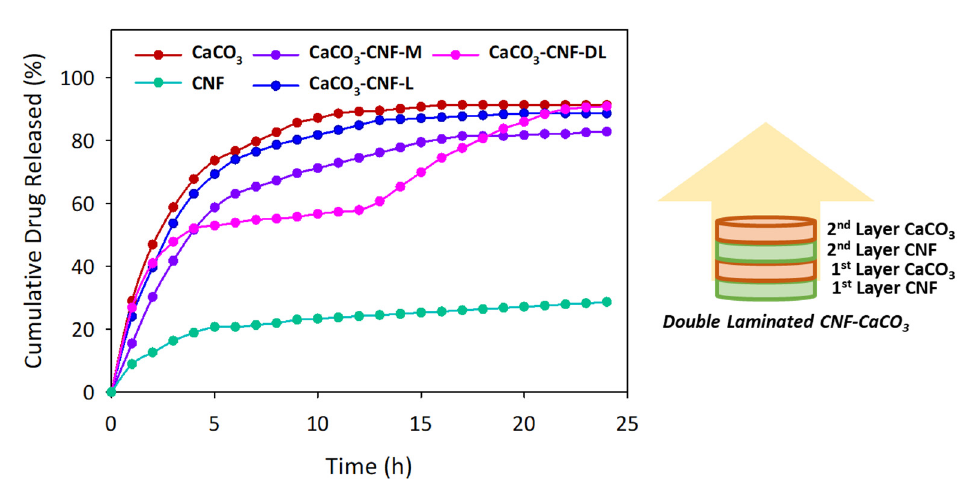
ff erent 3D printed films of CNF, CaCO